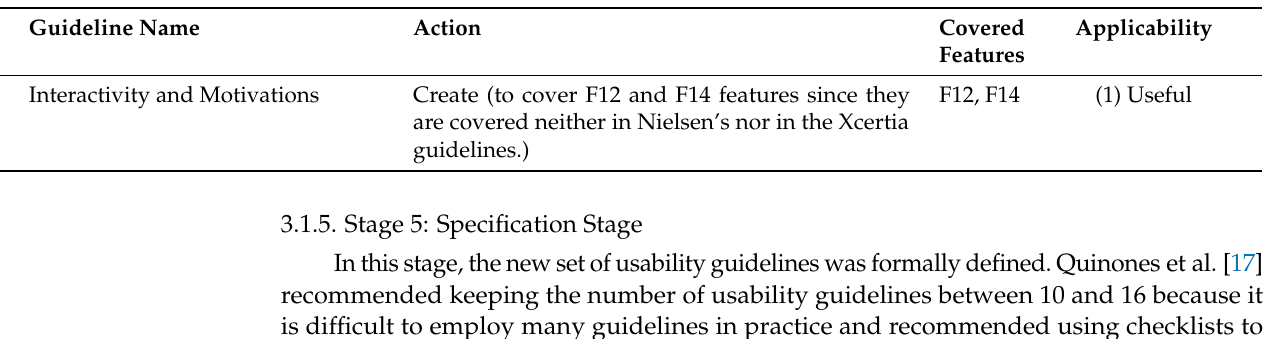
Table 6. Guideline selection process (new created guidelines).